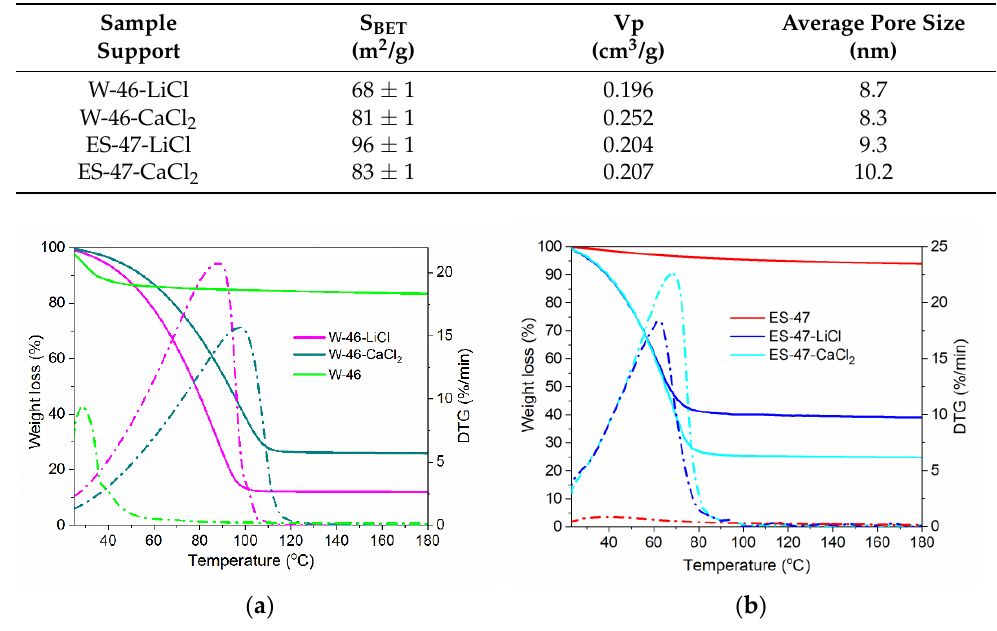
Figure 5. TG/DTG curves of the hydrothermally prepared support ( a ) W-46 and its composites and ( b ) ES-47 and its composites. ( b ) ES-47 and its